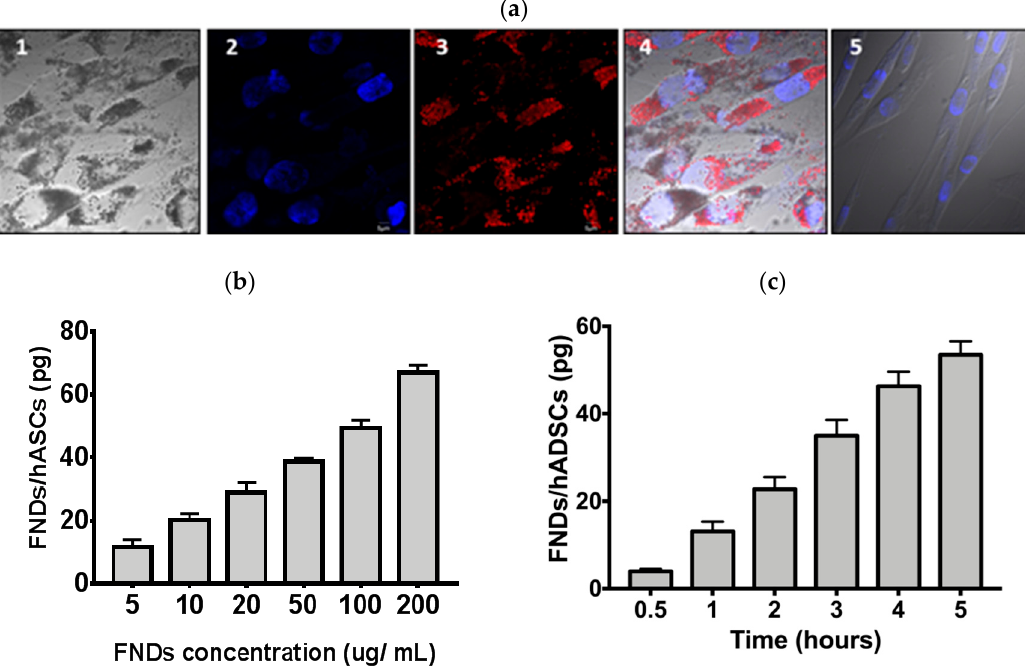
Figure 2. Characterization of fluorescent nanodiamond (FND)-labeled human adipose-derived stem/stromal cells (hASCs). ( a ) hASCs were incubated with 100 μ g/mL for 4 h. The fluorescent images of FND-labeled hASCs were obtained by a fluorescent microscope. Cell nuclei were stained by 4 ′ ,6-diamidino-2-phenylindole (DAPI). The images were shown: (1) bright-field, (2) DAPI, (3) FNDs, (4) the merged image, and (5) hASCs without FNDs. Scale bar: 20 μ m. ( b ) hASCs were incubated with FNDs at concentrations of 10–200 μ g/mL for four hours. Quantification of FNDs in the cells was performed and analyzed by magnetically modulated fluorescence (MMF). ( c ) hASCs were incubated with FNDs in a time-course manner (half to five hours) at 100 μ g/mL. The intracellular FNDs were subsequently analyzed by MMF.